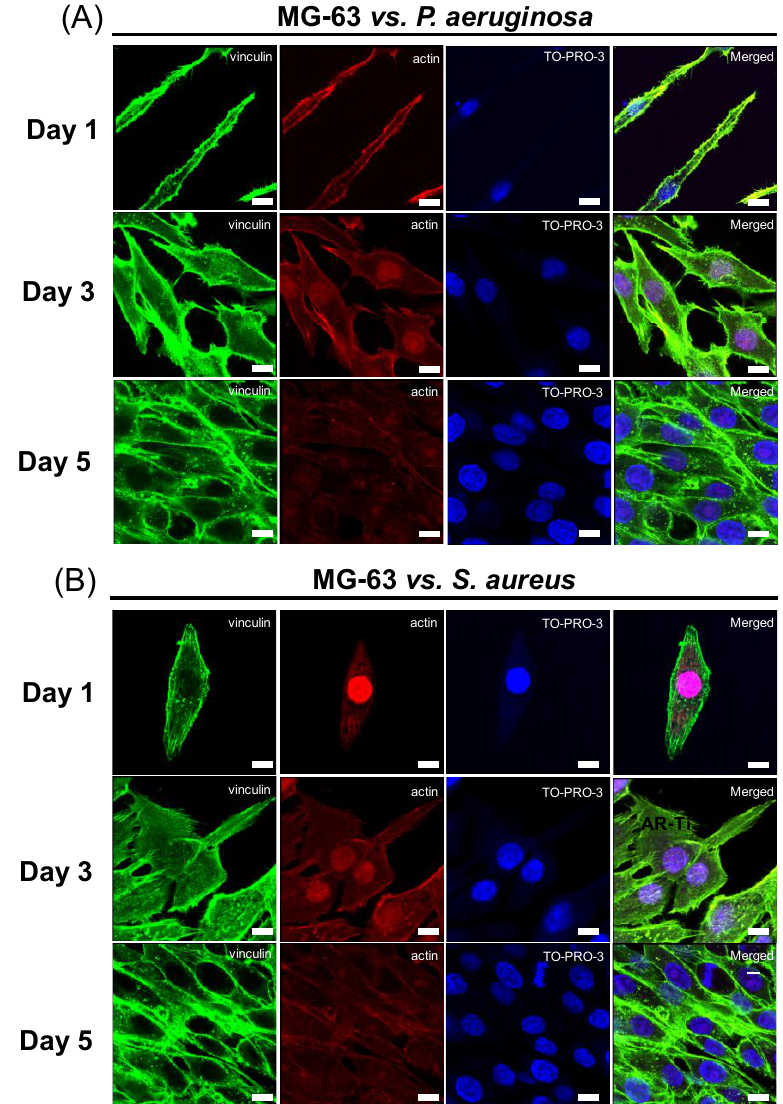
Figure 4. Immunohistochemical staining of proteins associated with growth and proliferation of MG-63 cells during their incubation on HTE-Ti surfaces pre-infected with ( A ) Pseudomonas aeruginosa and ( B ) Staphylococcus aureus cells. Vinculin is stained green, actin is red, and TO-PRO3 is blue. Cells were able to adhere to the pre-infected HTE-Ti surfaces and proliferate over the 5-day incubation period through the detection of the proteins responsible for attachment. (Scale bar = 20 µm).